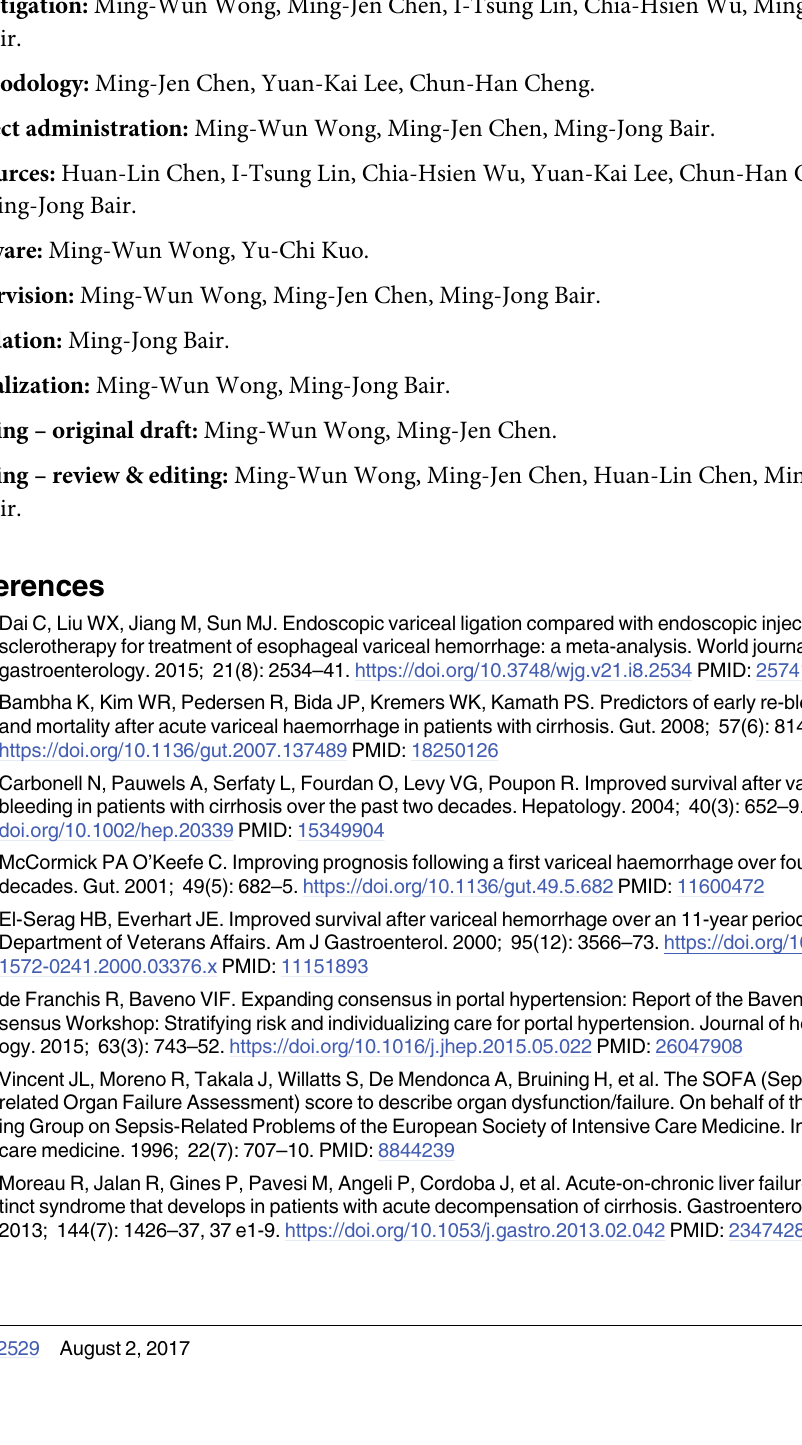
S4 Table. Original individual